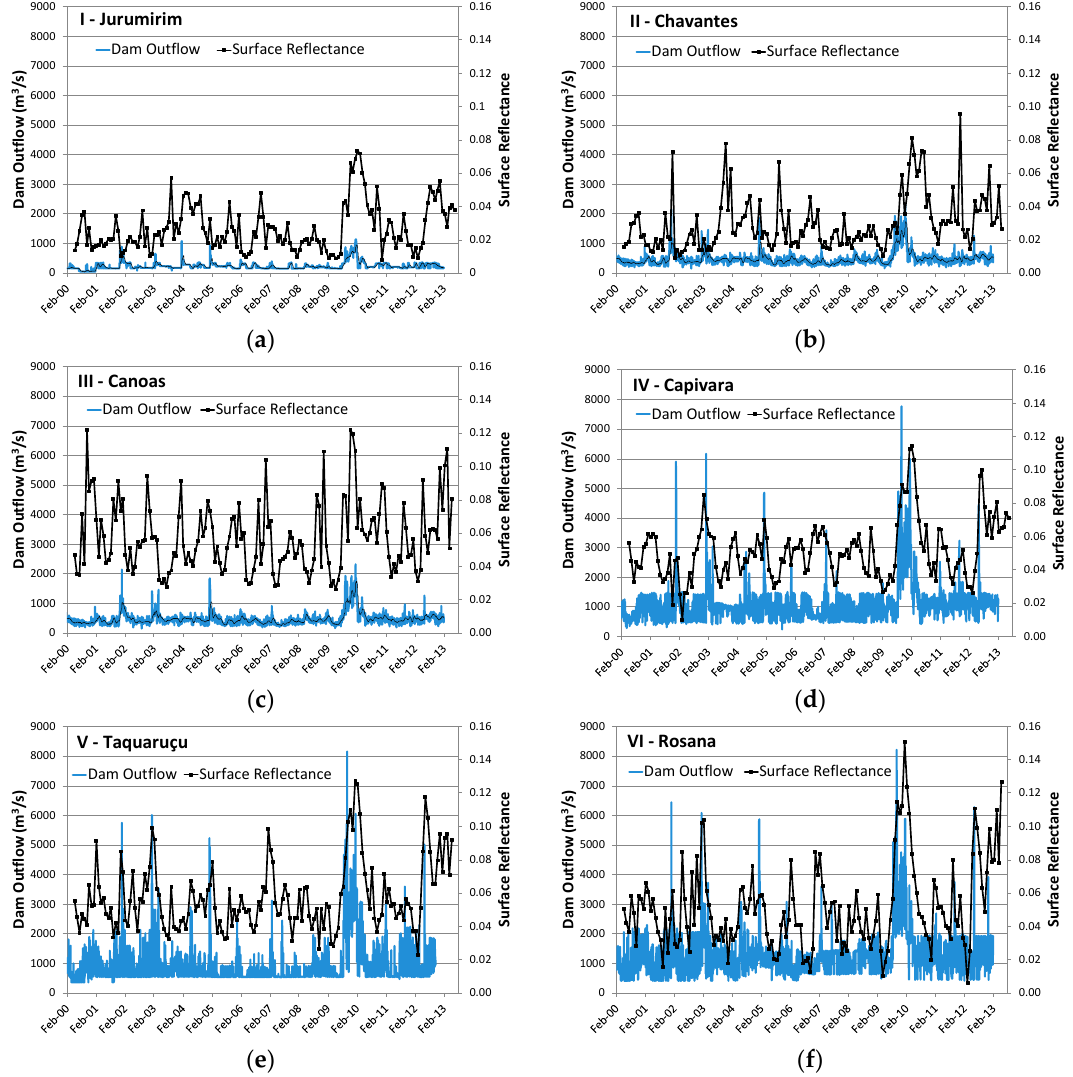
Figure 2. Daily dam water discharge and MODIS eight-day surface reflectance in red wavelengths retrieved from 2000 to 2013 for the six studied dams: ( a ) I-Jurumirim, ( b ) II-Chavantes, ( c ) III-Canoas II, ( d ) IV-Capivara, ( e ) V-Taquaruçu and ( f ) VI-Rosana.